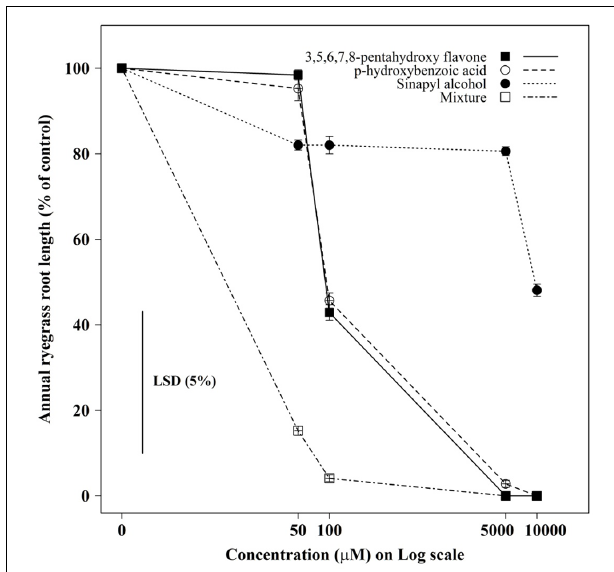
FIGURE 3 |The individual, and combined, effect of sinapyl alcohol, p -hydroxybenzoic acid, and 3,5,6,7,8-pentahydroxy flavone on the root growth of annual ryegrass seedlings. Data shown are the means ( n = 30; ± SE) of the root length of annual ryegrass seedlings. Data were pooled of three experimental units (beakers).The cross indicates significant difference between the genotypes × concentration interaction within one variables ( P < 0.05, ANOVA with post hoc Fisher-LSD-test).